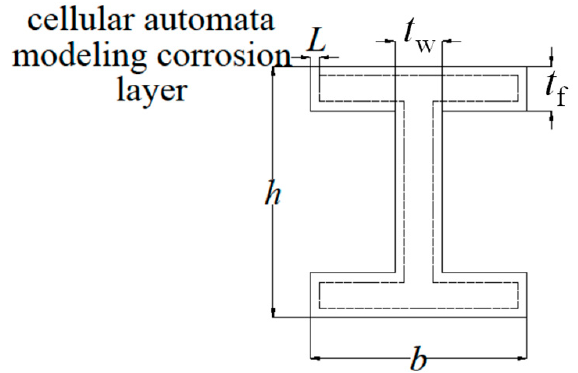
Figure 8. Schematic diagram of cell matrix slice section and attachment of H-beam section. The axis-shift theorem was applied to each cell matrix section, and the moments of inertia obtained after shifting each cell matrix section were summed to obtain the total moment of inertia in the corrosion simulation area. The areas of all cell matrix slices were also summed to obtain the total area. The corresponding schematic is shown in Figure 9, where the local coordinates refer to the coordinates of the cell matrix slice in Figure 7, and the overall coordinates refer to the coordinates of the H-beam.